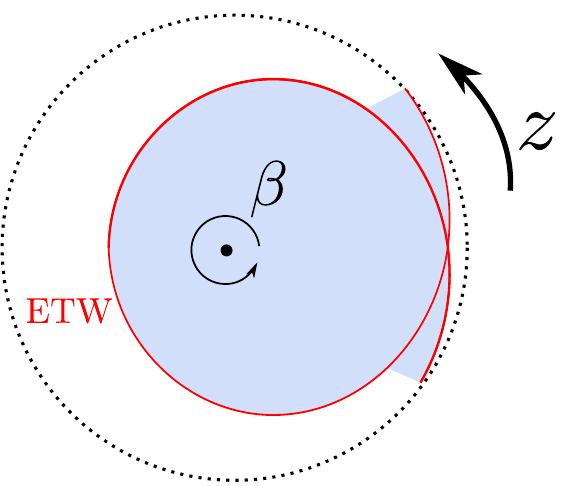
Figure 2 . Pathological Euclidean gravity solution with a self-intersecting ETW brane (red). The trajectory of the ETW brane in the Euclidean asymptotically AdS spacetime (blue) can be determined from the equations of motion; the fact that this trajectory self-intersects arises from the coordinate periodicity z ∼ z + β which must be imposed to ensure smoothness at the coordinate horizon (central